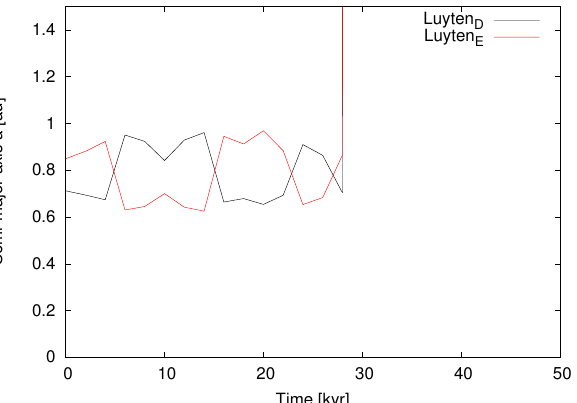
Figure 4. Case 3 ( e D = 0.0085, e E = nominal). Time evolution of the two outer planets over 10 Myr. In this unstable configuration the planets escape after undergoing a close encounter.